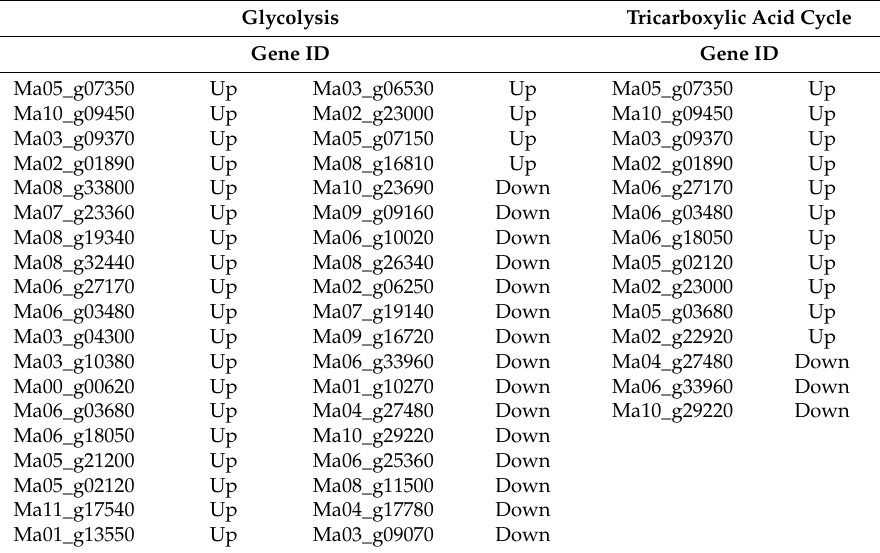
Table 2. Energy metabolism-related genes of aboveground